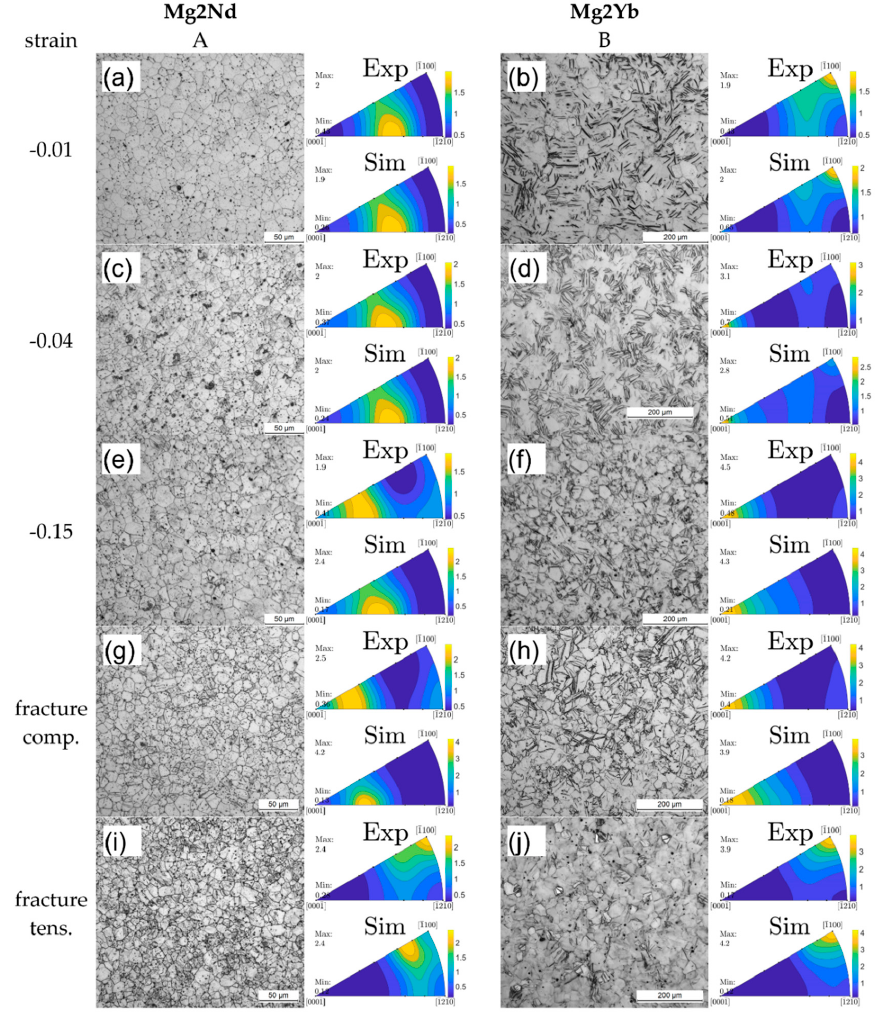
Figure 4. Cross sections and comparison of the measured and simulated texture at ( a , b ) − 0.01, ( c , d ) − 0.04, ( e , f ) − 0.15 strain and elongation to failure in ( g , h ) compression and ( i , j ) tension for the Mg2Nd A-series and the Mg2Yb B-series, respec- tively.